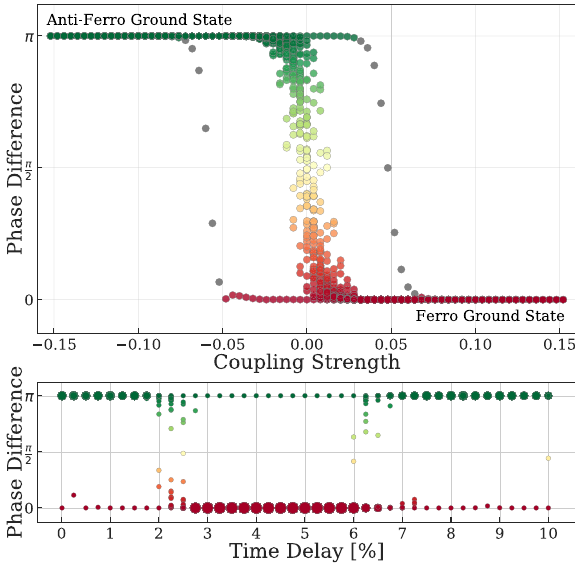
Figure1: Top:Phasedifferenceasafunctionofcouplingstrengthfor a polariton dyad. The Eqs. (7) and (8) are simulated for 50 random initial conditions for each coupling value. The coherence occurs for the absolute values of strengths greater than 0.02 leading to ferromagnetic state with 0 phase difference for positive couplings and to antiferromagnetic state with π phase difference for negative couplings. The slowly decaying unstable solutions are shown in grey. Bottom: Phase difference as a function of time-delay for a polaritondyad.The time-delaypercentageis de fi nedwithrespectto thetimerequiredtoreachasteadystateintheabsenceofdelay.The scatter point size indicates how many states out of 50 initial conditions end with a particular phase difference. The coupling strength between condensates is chosen to be J 0 (cid:1) − 0 . 1. The expected anti-ferromagnetic state is observed for time-delays τ < 2% and followed by the region with decoupledcondensates.The further phase-locking of condensates becomes possible for bigger time-delays due to the global phase